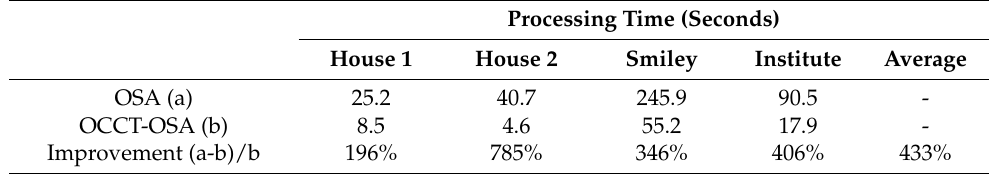
Table 8. Processing time by OCCT-OSA and OSA.